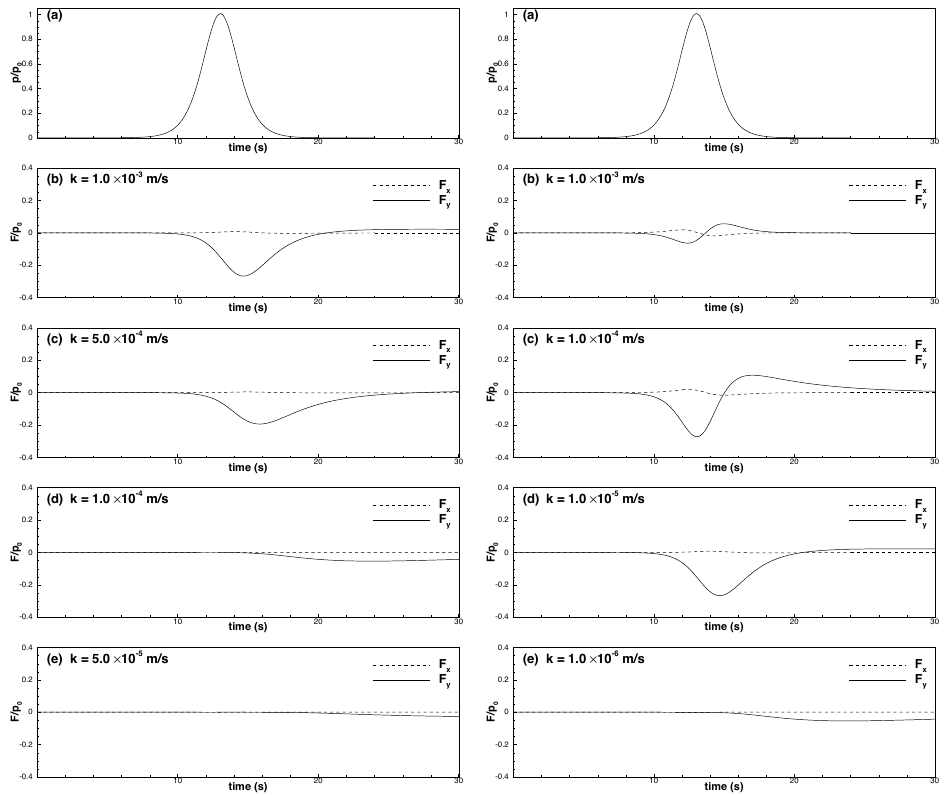
Figure 13. Time evolution of seepage force exerted on the pipeline at various k values and left : E = 1.0 × 10 3 kPa; right : E = 1.0 × 10 5 kPa. ( a ) Dynamic pressure at the seabed above the pipeline; ( b – e ) horizontal and vertical components of seepage force at different k value.